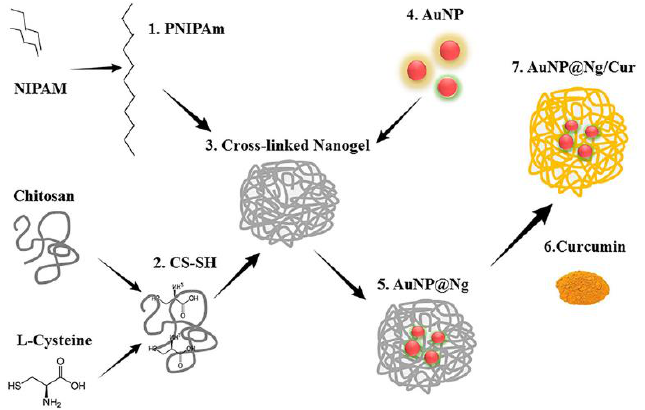
Figure 2. Schematic of production of a cross-linked nanogel by Howali et al. (From [47]).